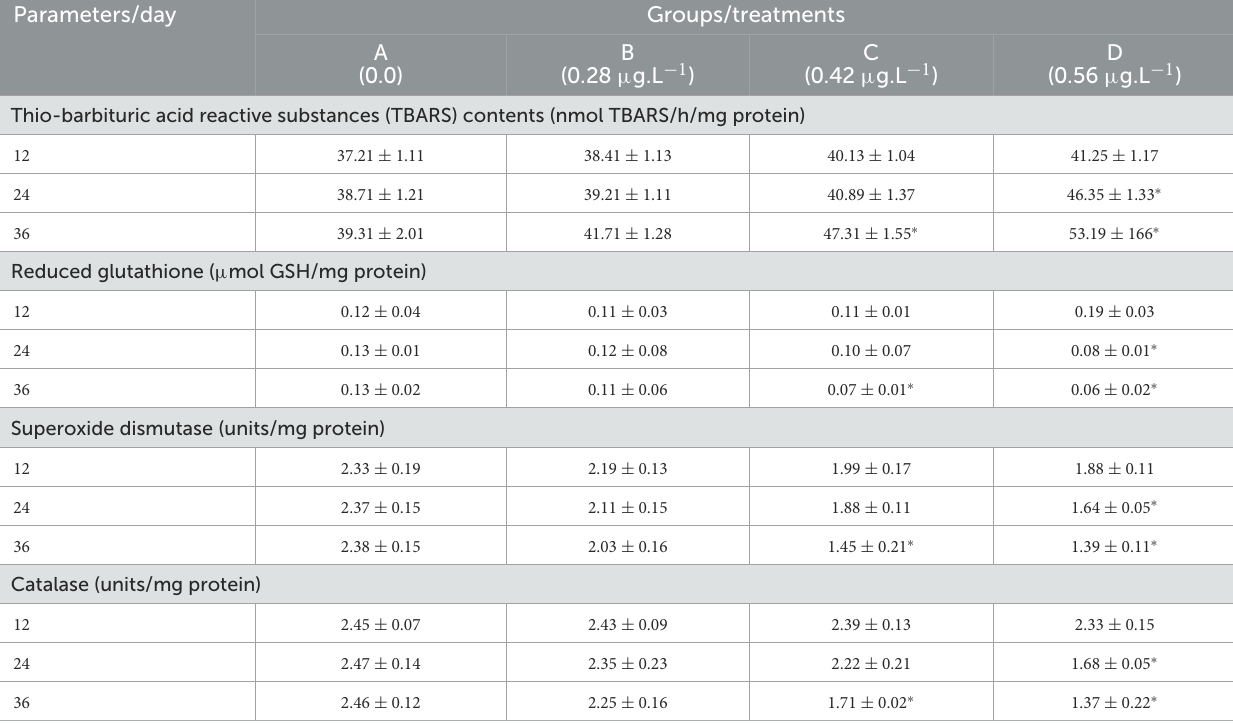
TABLE 6 Oxidative stress and antioxidant enzymes in erythrocytes of fish ( Labeo rohita) treated to copper sulfate.